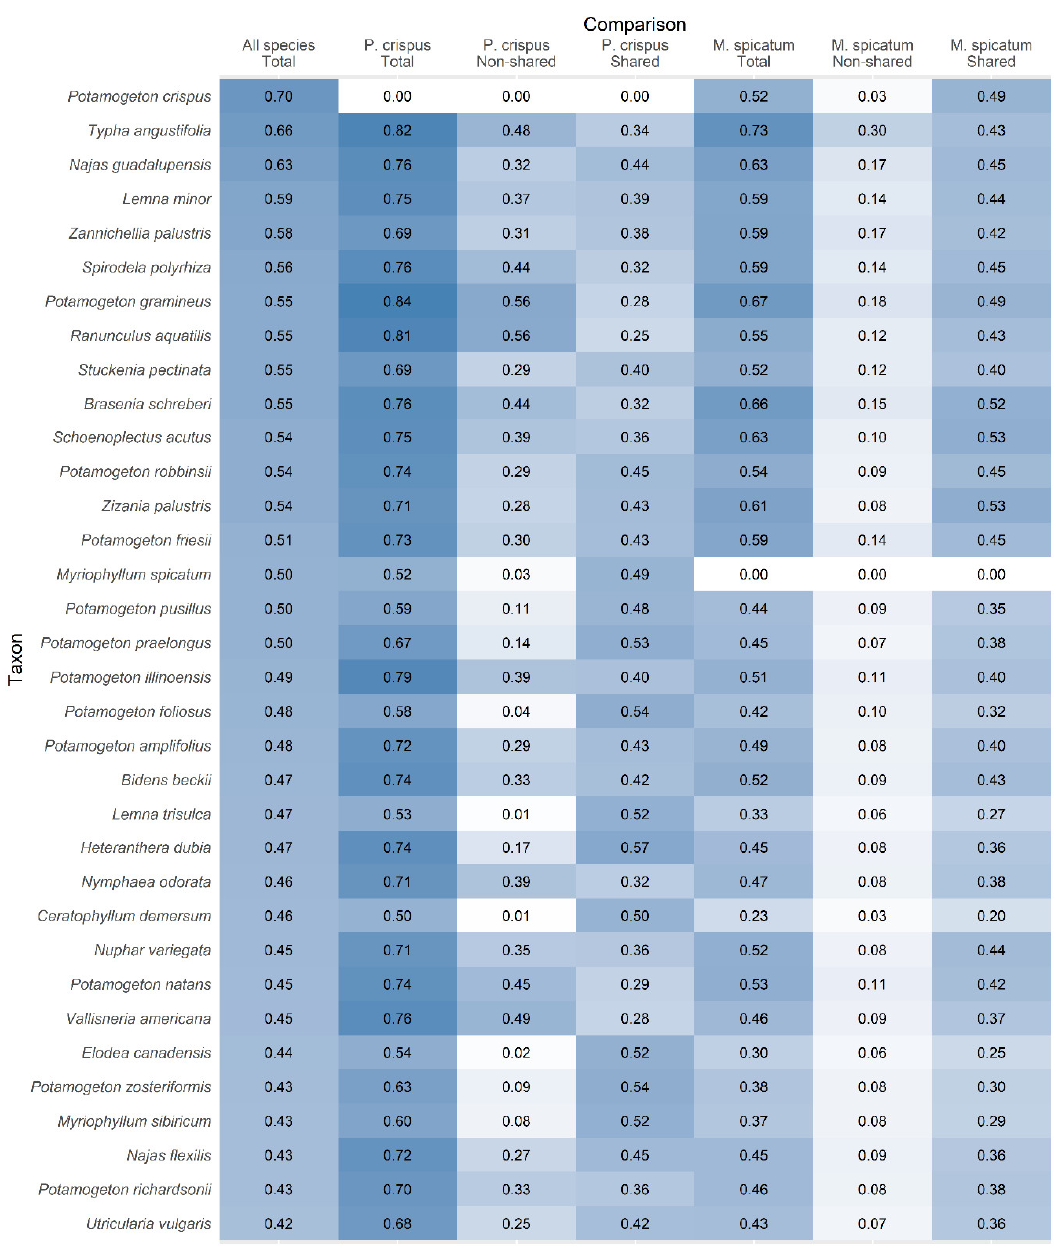
Figure 5. Probabilistic niche dissimilarity between Potamogeton crispus, Myriophyllum spicatum , and 32 native species. Species are sorted according to their total dissimilarity to other species (mean of each species’ 33 pairwise comparisons). Shading corresponds with numeric values to facilitate visual comparisons.